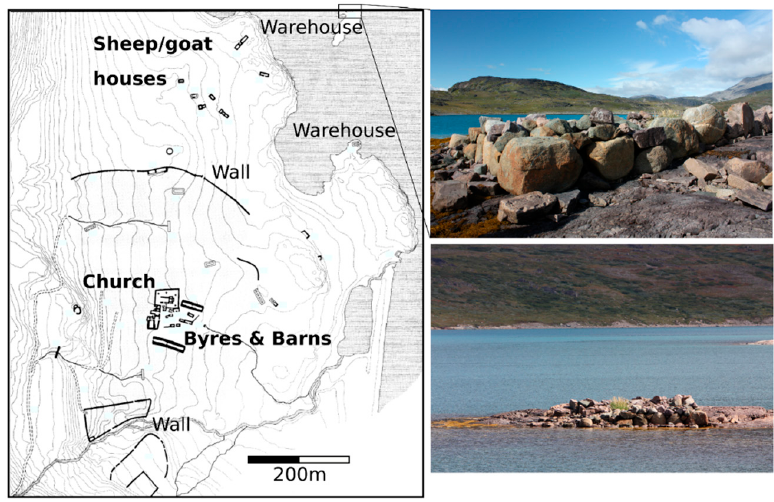
Figure 2. Site plan of Igaliku with the Norse ruins (plan after Knud J. Krogh, from [10], Figure 24). The images show the ruins of one of the coastal warehouses.